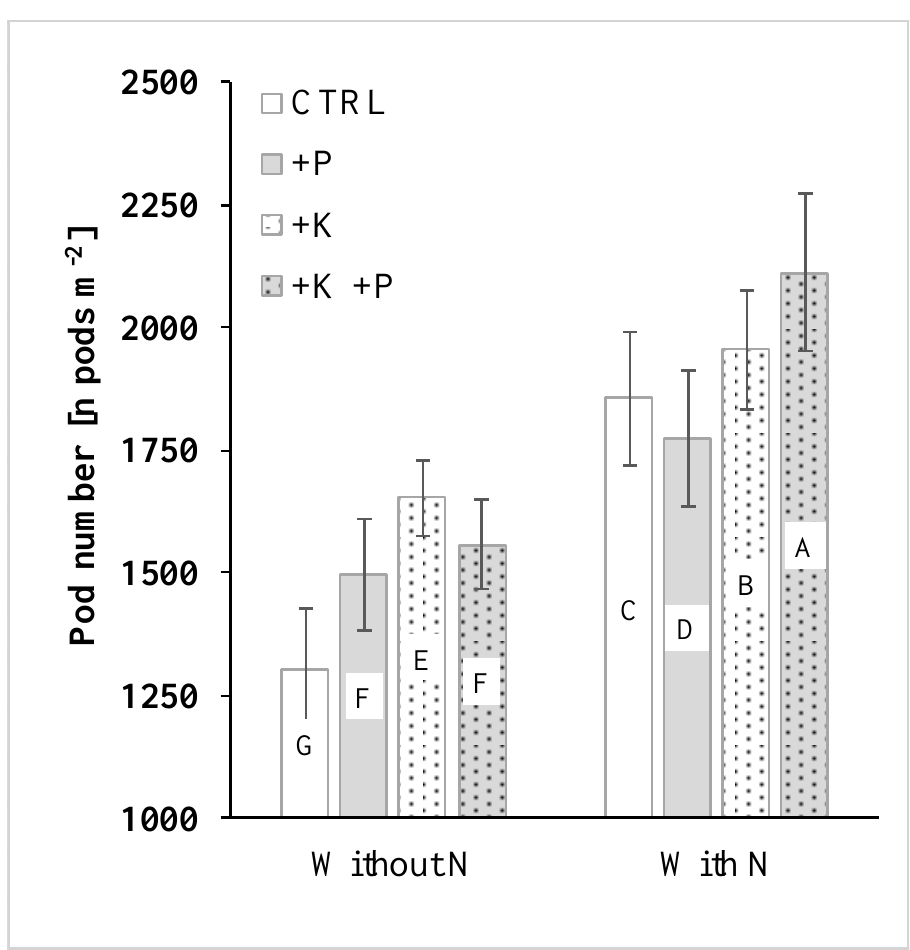
Figure 4. Least squares means (LSmeans) and standard error of the LSmeans of the number of pods per unit area in Oenothera biennis L. local genotype (Evening Primrose) and Brassica napus L cv. serw 1 (Rapeseed) grown in 2 growing seasons in a P and K deficient soil and fertilized with 142.9 kg N ha − 1 , 171.4 kg K 2 O ha − 1 , or 36.9 kg P 2 O 5 ha − 1 . Data are means of the species. Means with a letter in common cannot be considered different according to a conservative Tukey-grouping applied to the p differences of the LSmeans. N = 12. Please note that error bars are standard error estimates of the LSmeans and not the computed standard error, which can be found in Supplementary Materials Table S1. CTRL indicates a lack of P and K